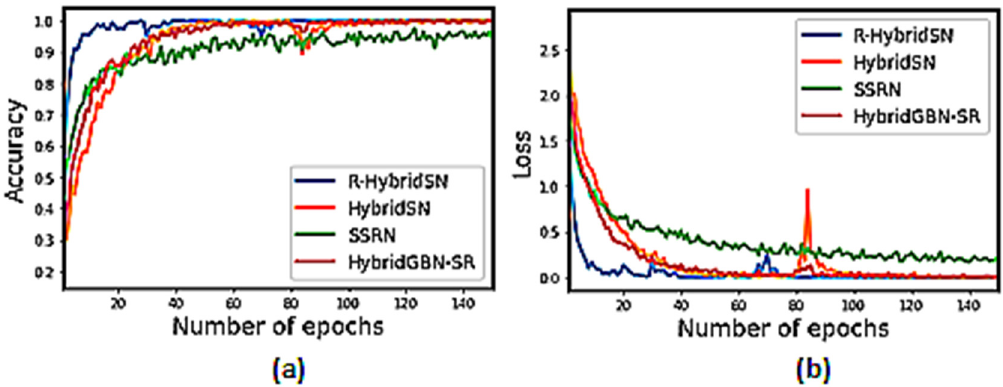
Figure 11. Training graphs for R-HybridSN, HybridSN, SSRN, and HybridGBN-SR for each epoch over UP dataset: ( a ) The training accuracy graph; ( b ) The loss convergence graph.